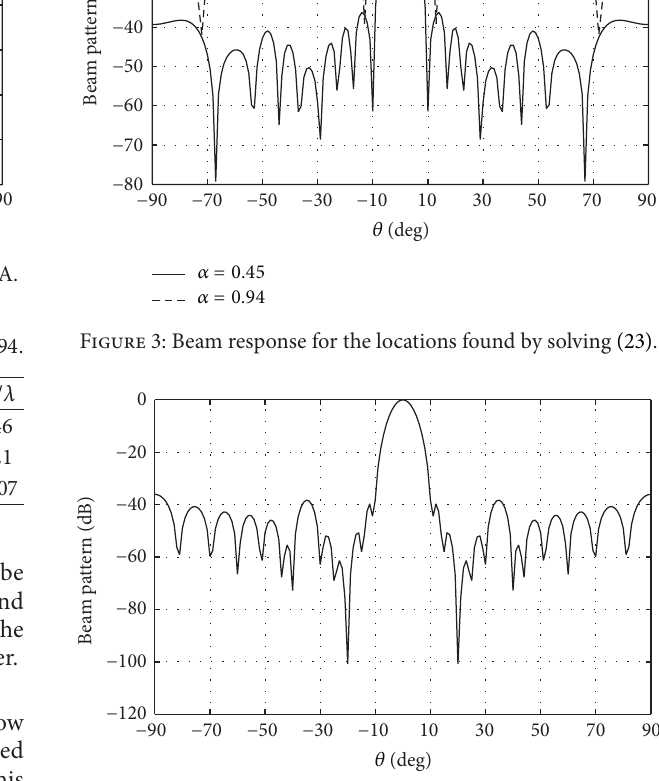
Figure 4: Beam response for the locations found by solving (24). Table 2: Locations found from solving (24) with a value of 𝛼 = 0.45